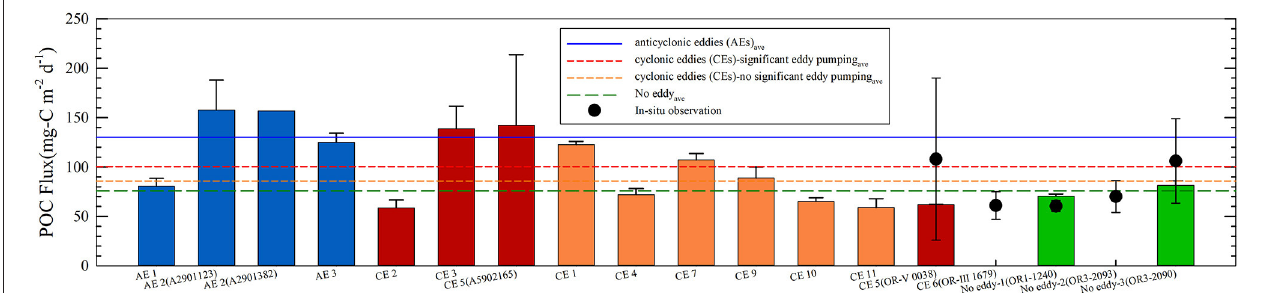
FIGURE 8 | Particulate organic carbon (POC) fluxes for the eddy cases based on in situ observation (solid circles) and satellite estimation (color-shaded bars). The bars in blue, red, orange, and green show the POC fluxes corresponding to the cases with significant anticyclonic eddies (AEs) pumping, significant cyclonic eddies (CEs) pumping, insignificant CEs pumping, and no eddies, respectively. All error bars show the standard deviation of the POC fluxes. The horizontal solid and dashed lines show the total mean of POC flux for each case based on satellite estimation. We performed direct measurement of the POC flux given by Shih et al. (2020) for CE5 (OR-V 0038) and CE6 (OR-III